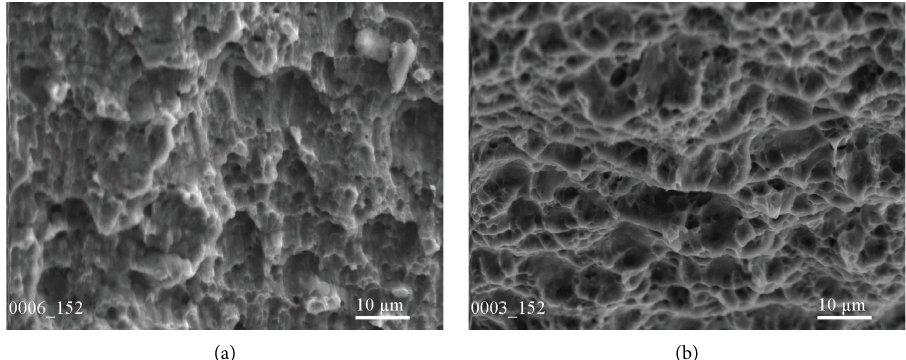
Figure 16: Fracture surface of rolled samples after tensile testing at 20 ° C: (a) after the frst stage of processing ( h � 1.6mm); (b) after the second stage of processing ( h �